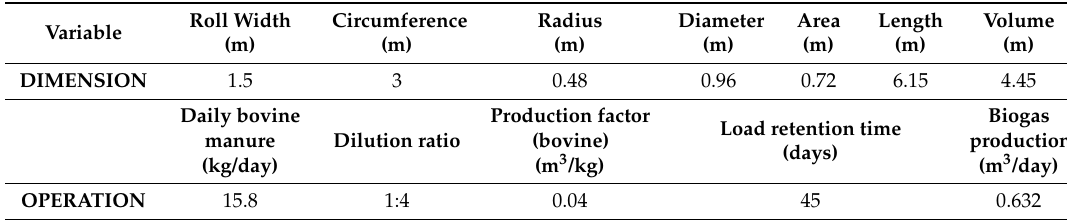
Table 6. Dimensions and operational characteristics of the biodigestor.